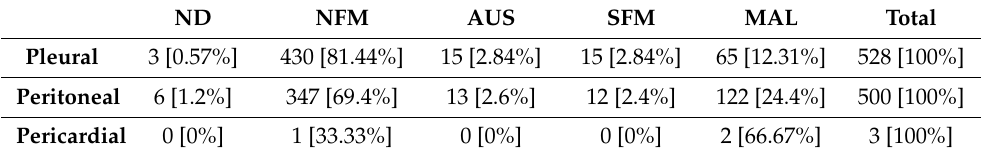
Table 1. Number and distribution of pleural, peritoneal and pericardial effusions per TIS category.